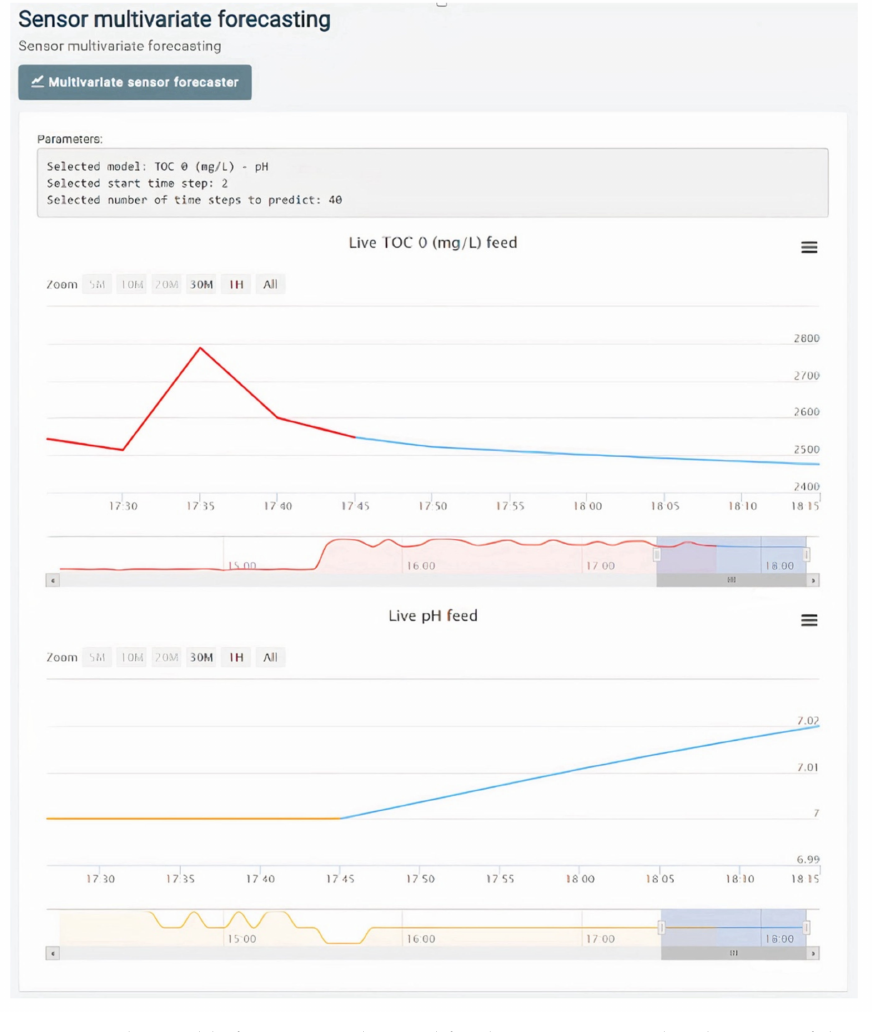
Figure 5. Multivariable forecasting, depicted for the TOC measured at the input of the module and the pH of the water. Red (yellow) lines correspond to the values measured for TOC(pH), with blue lines depicting the forecasts of the